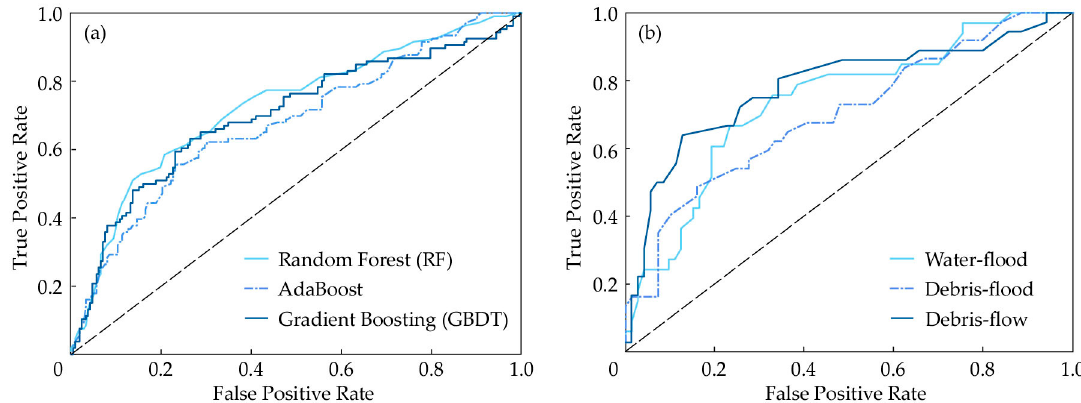
Figure 6. Receiver operating characteristic (ROC) curve and area under the receiver operating characteristic curve (AUROC) for ( a ) the testing dataset and ( b ) multi-class with RF.